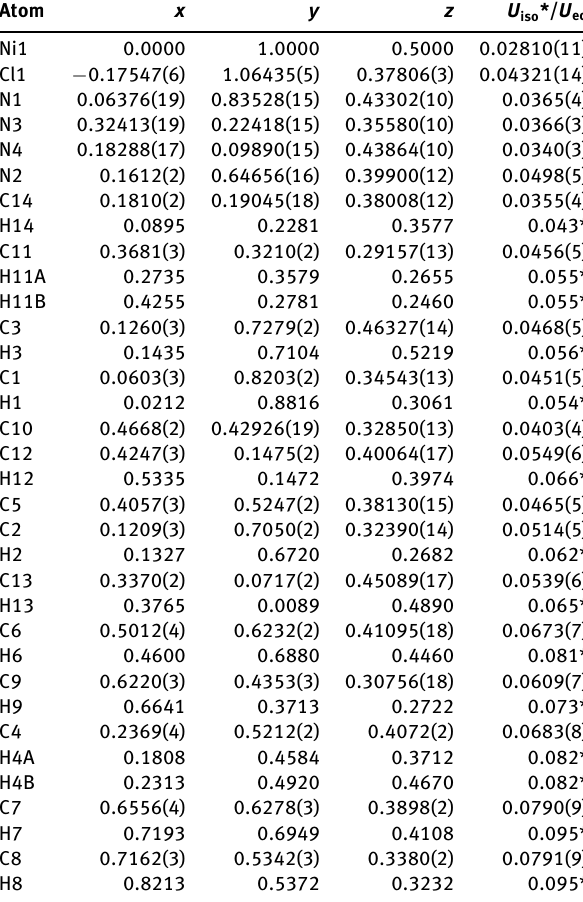
Table 2: Fractional atomic coordinates and isotropic or equivalent isotropic displacement parameters (Å 2